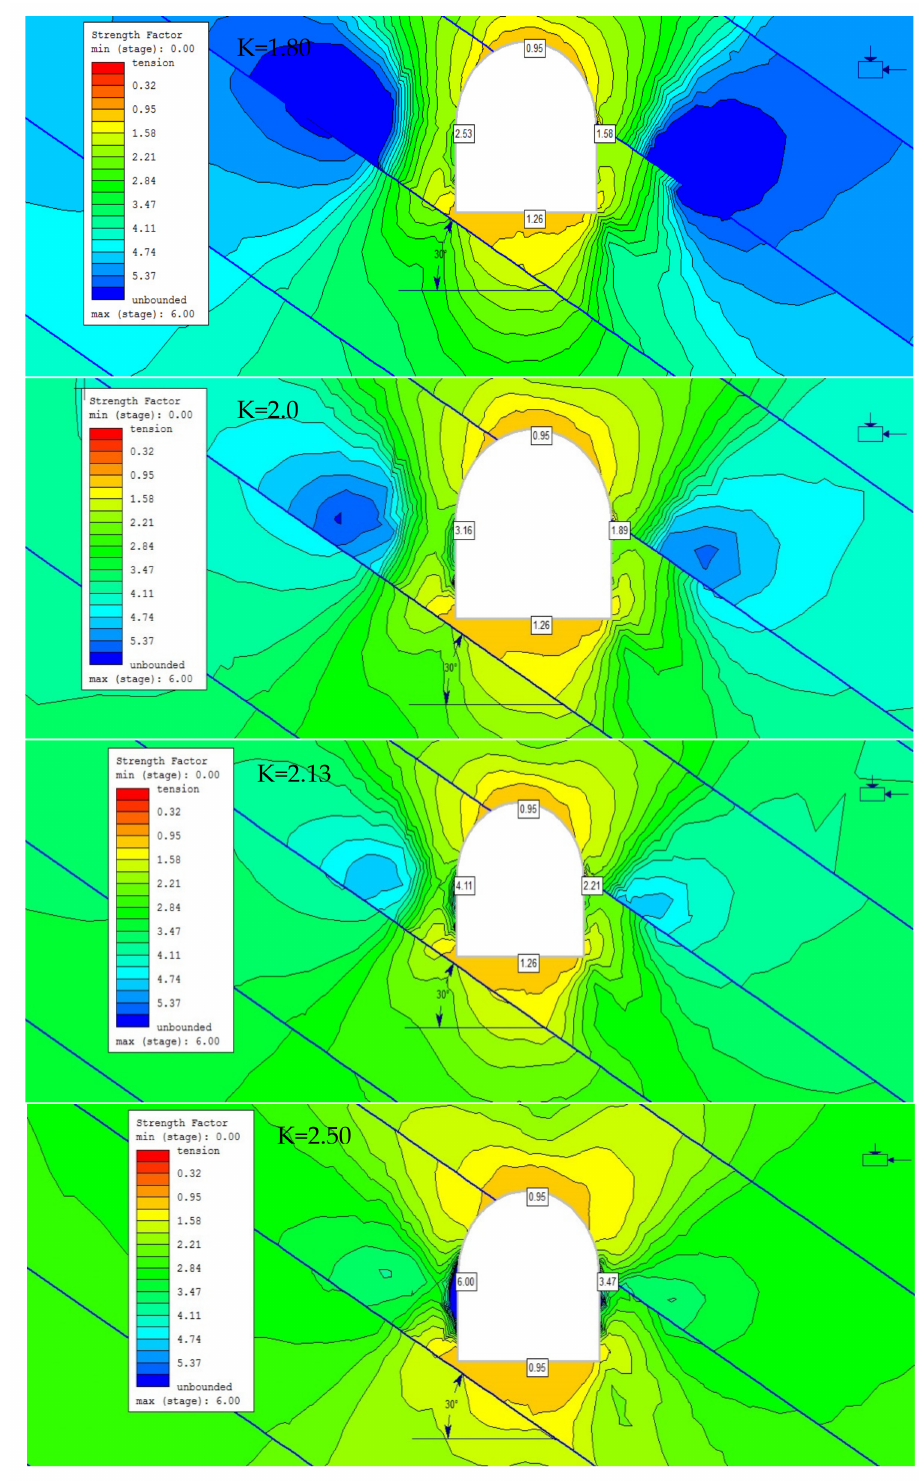
Figure 10. Strength contours of rock mass around tunnel opening at different states of in situ